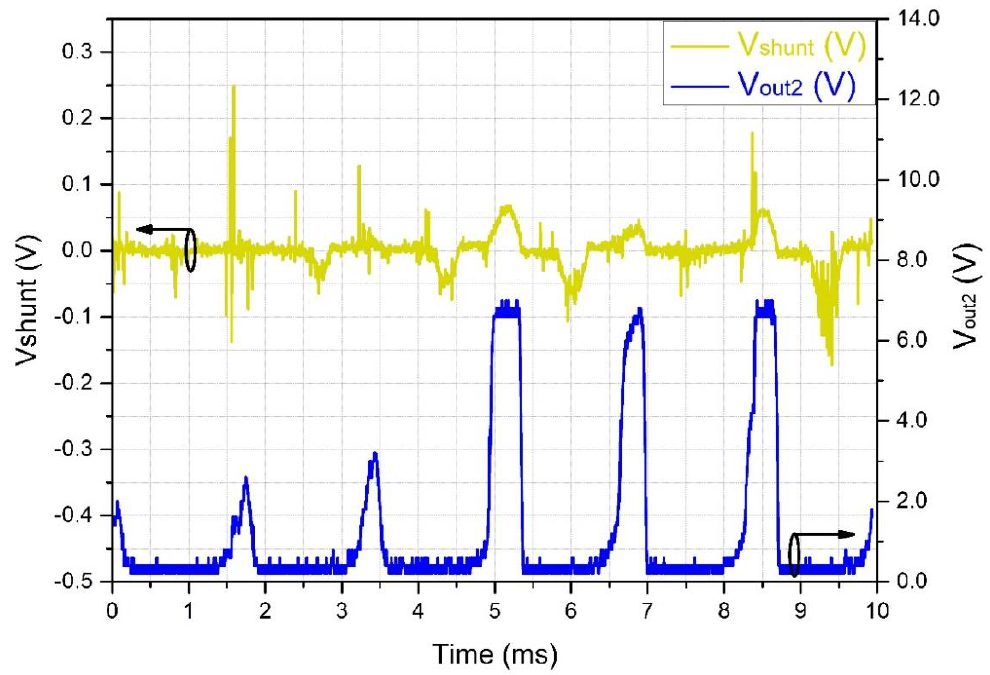
Figure 13. Effect of the RMS converter on partial discharge pulses. Upper line: signal captured by the shunt resistor. Bottom line: signal captured by the OSM after the RMS converter, showing wider pulses when the bursts increase in length (black circles around curves indicate the related vertical axis).